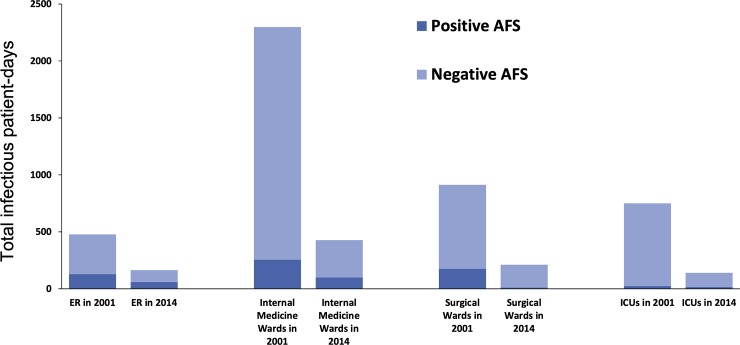
Total non-isolated infectious patient-days from hospitalized patients with culture-confirmed tuberculosis, 2001 vs. 2014.Abbreviations: AFS, acid-fast smear; ED, emergency department; ICUs, intensive care units. Internal medicine wards: general medicine, cardiovascular medicine, pulmonary medicine, endocrinology, gastro-enterology, hematology, infectious diseases, nephrology, oncology, and paediatrics. Surgical wards: cardiovascular surgery, neurosurgery, otolaryngology, general surgery, chest surgery, proctology, ophthalmology, orthopaedics, plastic surgery, and urology.